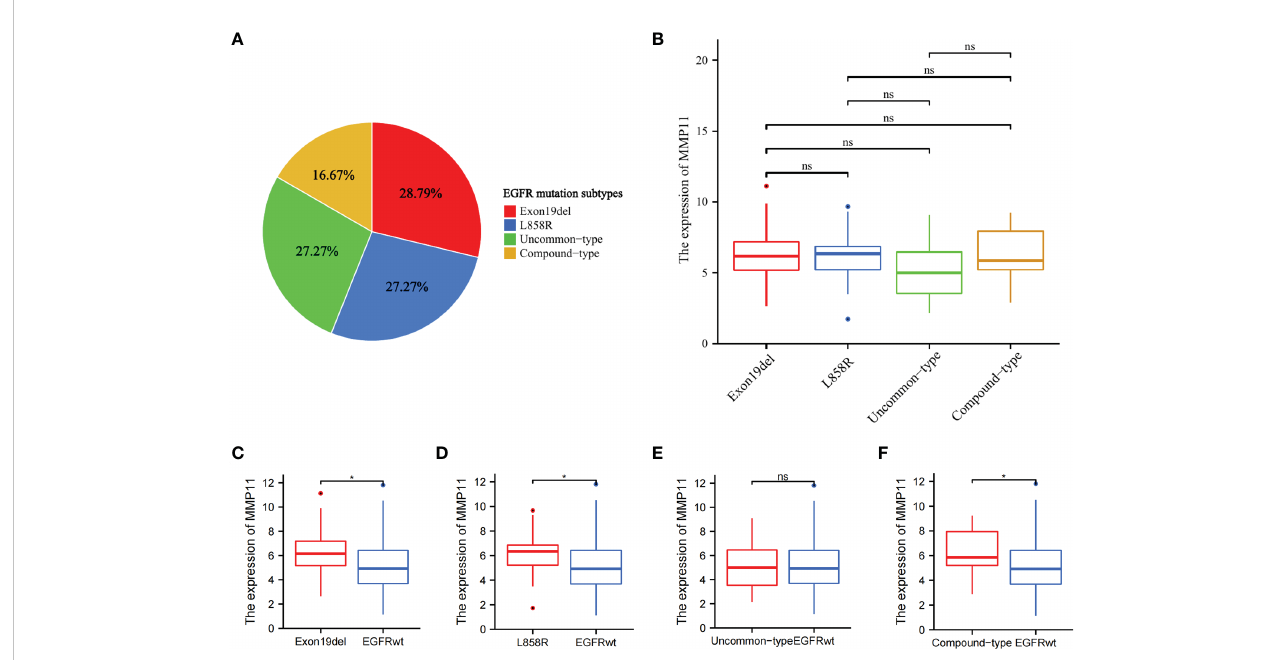
FIGURE 2 Differential expression of MMP11 between different EGFR mutation subtypes at the mRNA levels. (A) Proportion of EGFR-mutant samples by mutation subtypes among 66 EGFR-mutant LUAD, the Exon19del group is red, the L858R group is blue, the uncommon-type group is green and the compound- type group is yellow (pie chart; TCGA); (B) Differential expression of MMP11 in samples with different EGFR mutation subtypes at the mRNA level (TCGA); (C) Differences in MMP11 mRNA expression between the Exon19del and EGFR-wild groups (TCGA-LUAD); (D) Differences in MMP11 mRNA expression between the L858R and EGFR-wild groups (TCGA-LUAD); (E) Differences in MMP11 mRNA expression between the uncommon-type group and EGFR- wild groups (TCGA-LUAD); (F) Differences in MMP11 mRNA expression between the compound-type group and EGFR-wild groups (TCGA-LUAD); *P < 0.05; ns, no statistical signi fi